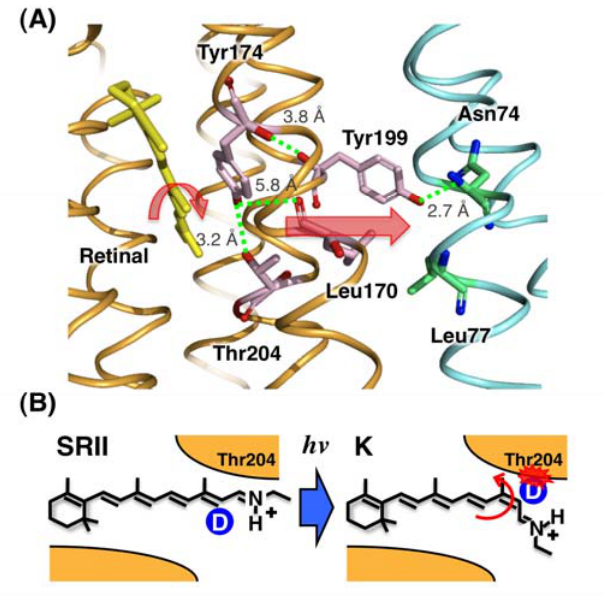
Figure 4. (A) Detail of the SRII-HtrII X-ray structure, which focuses on the midmembrane SRII-HtrII interface containing the core signal relay structure. SRII and HtrII are colored orange and blue, respectively. The numbers in the smaller font are the length between the respective amino acid residues. Using FTIR spectroscopy and photochemical techniques, we and another group reported that Thr199 SRII forms a hydrogen bond with Asn74 HtrII [56,79]. A functionally important residue, Thr204 SRII , forms a hydrogen bond with Tyr174 SRII . Tyr174 SRII is also essential for the phototaxis function [81]. (B) The structural change of the retinal chromophore upon formation of the K intermediate of SRII. All seven monodeuterated all- trans retinal analogues were synthesized, and the FTIR spectra were -D stretch in the K intermediate was assigned as the measured at 77 K. The enhanced C 14 band originating from the local steric constraint between C -D and Thr204 SRII [75,80]. We 14 reported that the band intensity correlated well with the phototaxis signaling efficiency, indicating its functional importance